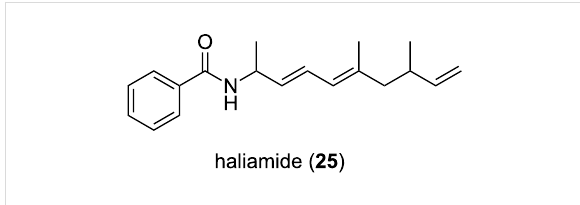
Figure 11: Structure of haliamide from H. ochraceum SMP-2.